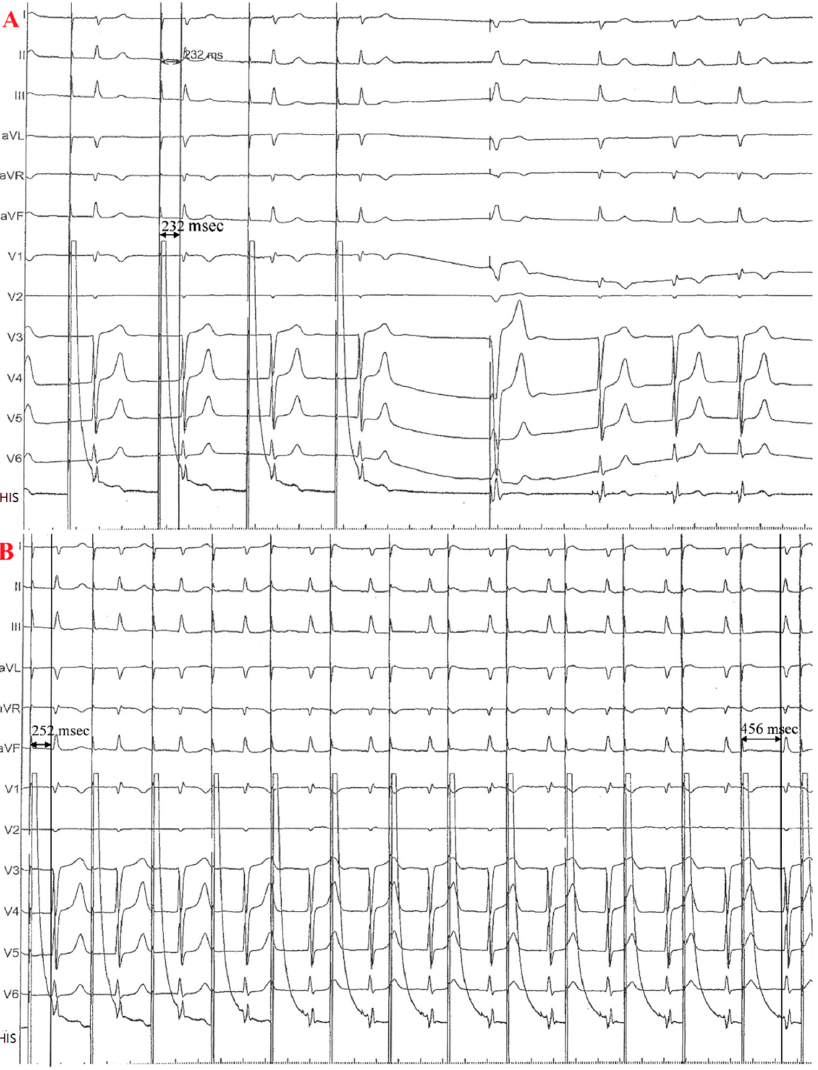
Figure 2. EGM during the implantation. ( A ), S-QRSonset was 232 ms when paced at a rate of 60 BPM at site A. ( B ), S-QRSonset progressively lengthened from 256 ms to 456 ms when the pacing rate was 90 BPM at site A.